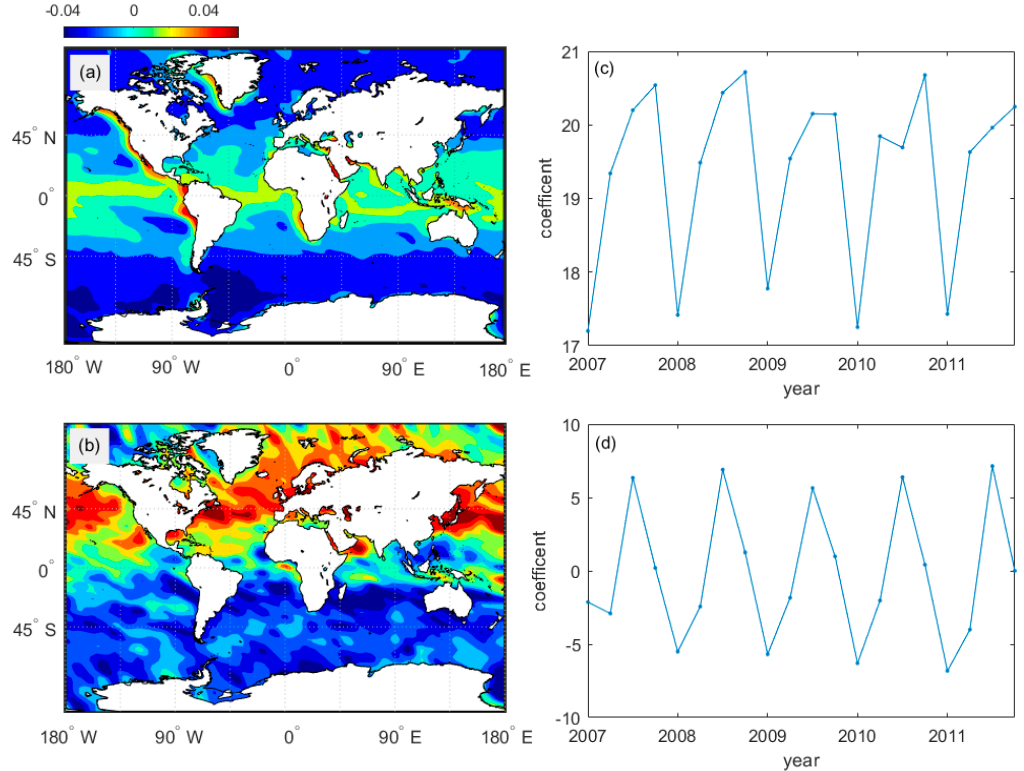
Figure 11. ( a , b ) The two modes of MBLH global distribution from 2007 to 2011. The colorimetric region is the MBLH anomaly; ( c , d ) The time coefficient corresponding to two